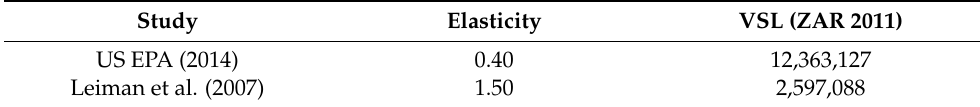
Table 2. VSL for South Africa in ZAR 2011. Study